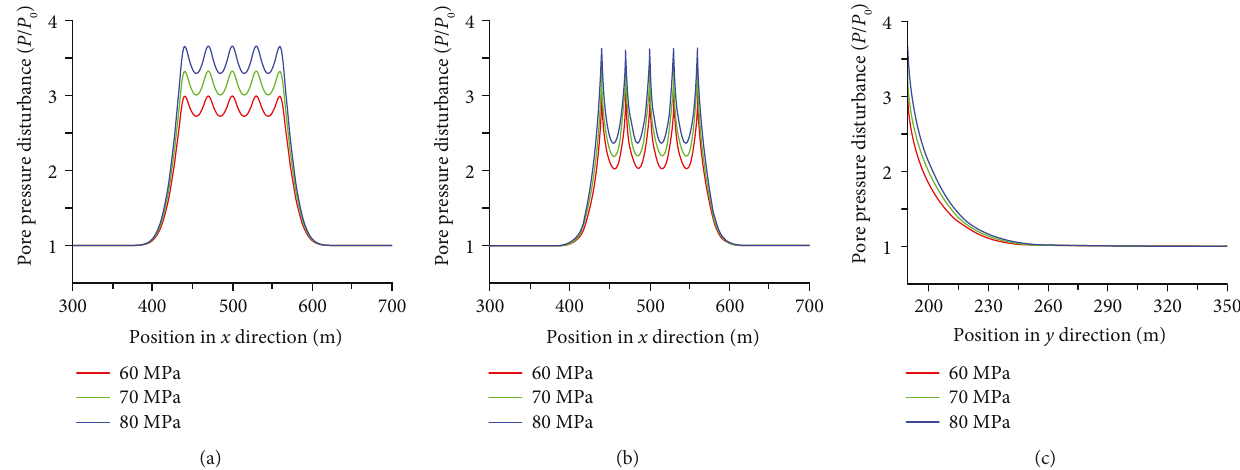
Figure 6: Pore pressure disturbance for di ff erent fracturing pressures at t = 4 h: (a) for data output line 1, (b) for data output line 2, and (c) for data output line 3.